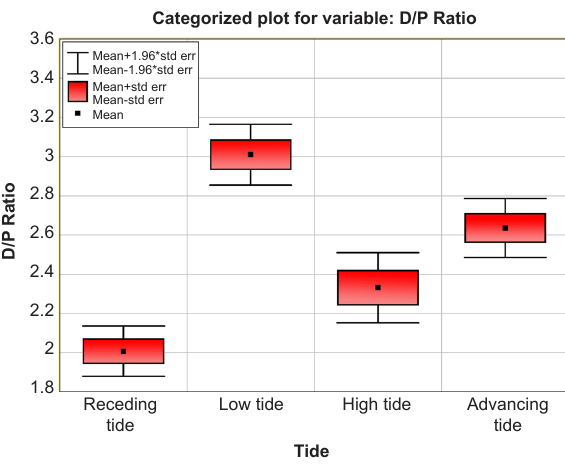
Figure 4. Relation between dive duration during different tidal cycles.